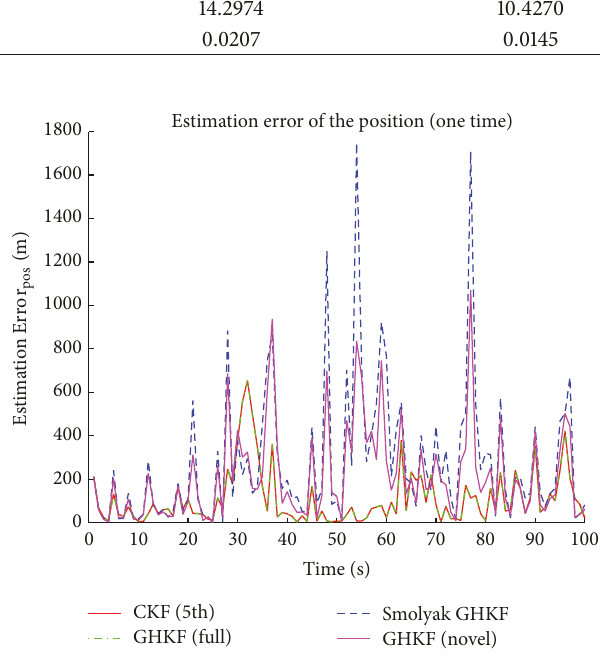
Figure 2: Estimation error of position (one simulation).